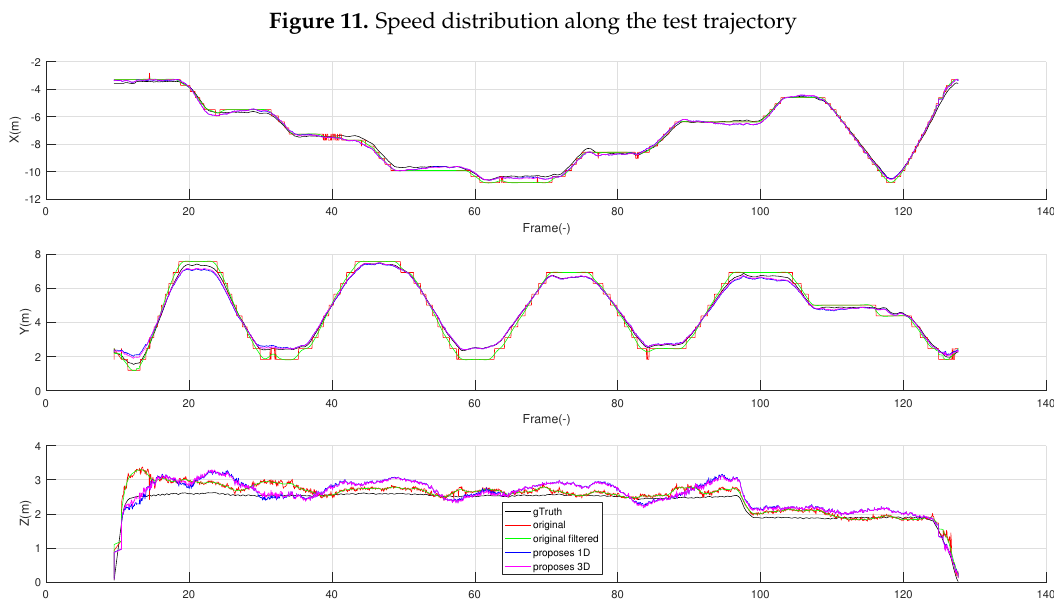
Figure 12. Comparison of all methods divided among the xyz coordinates. The one-dimensional version in blue, 3D in magenta, the default version in red, this last filtered in green, and the ground truth reference in